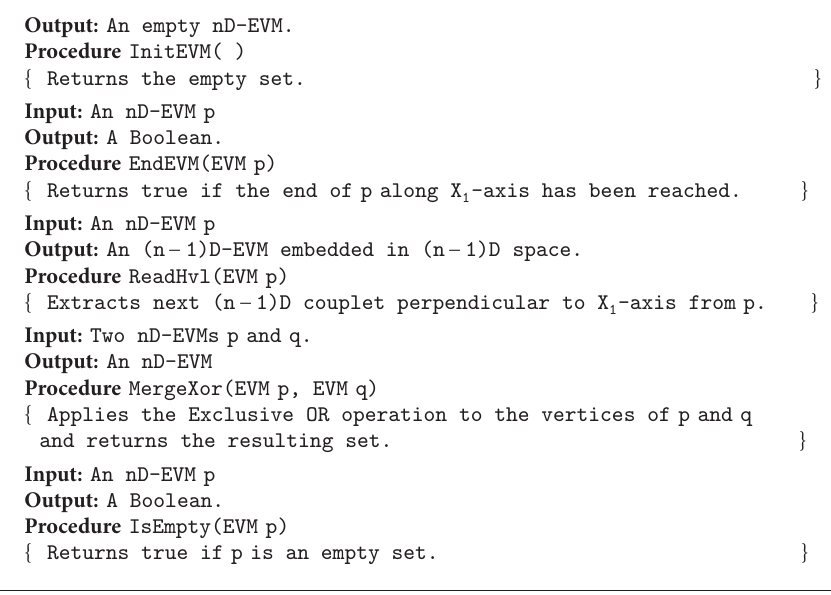
Algorithm 1: Some primitive operations in the 𝑛